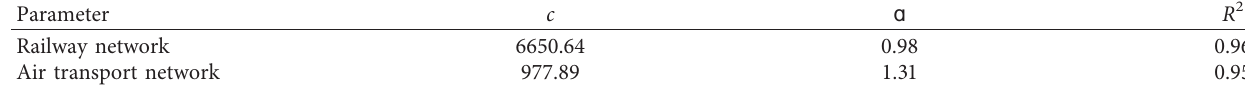
Table 3: Power function parameters of China railway and air transport networks.